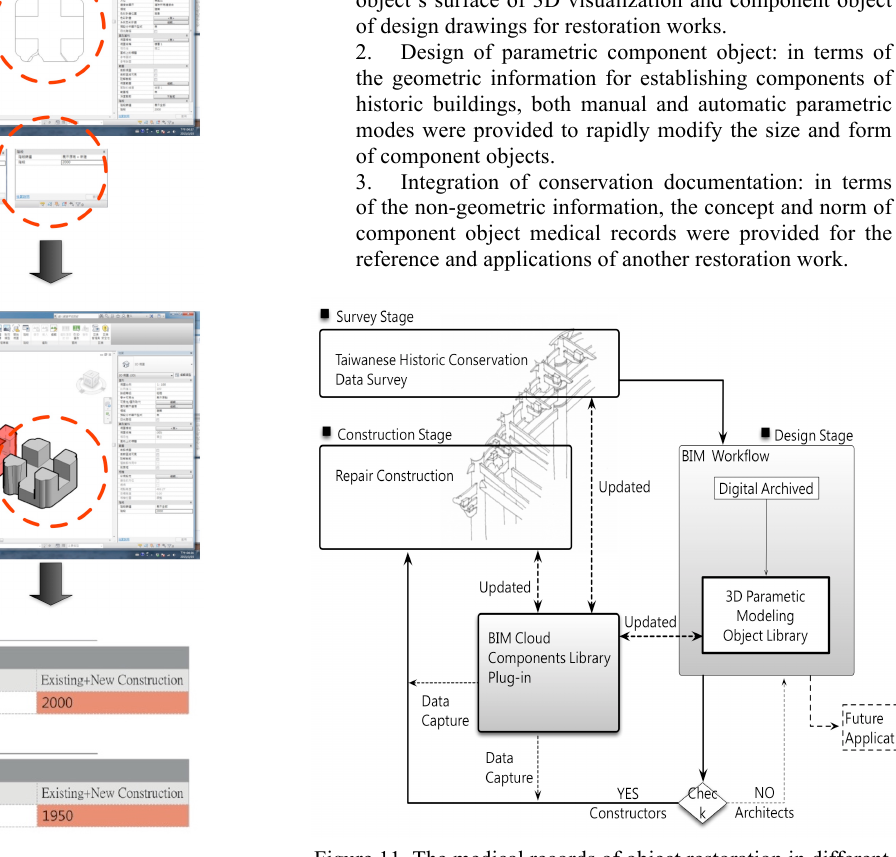
Figure 11. The medical records of object restoration in different